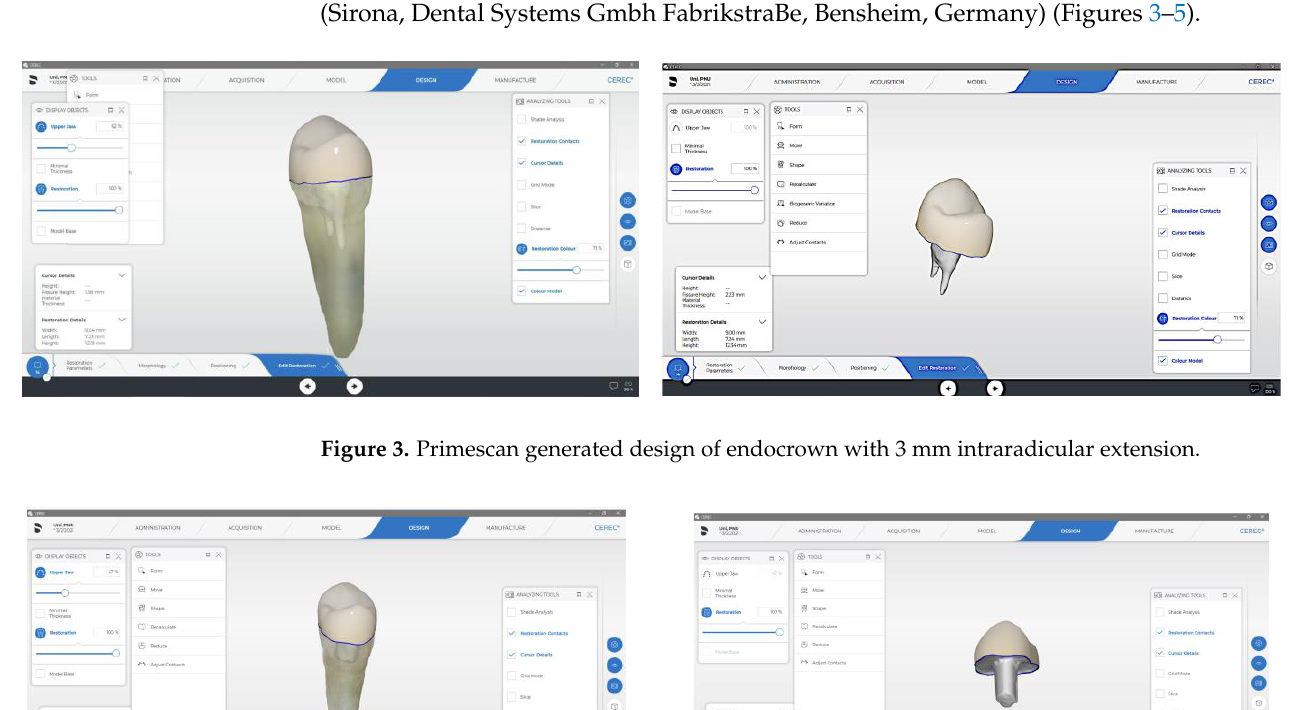
Figure 2. ( a ) Radiographic proximal view of Endocrown preparation with 3 mm intraradicular extension. ( b ) Occlusal view of Endocrown preparation wit 3 mm intraradicular extension.